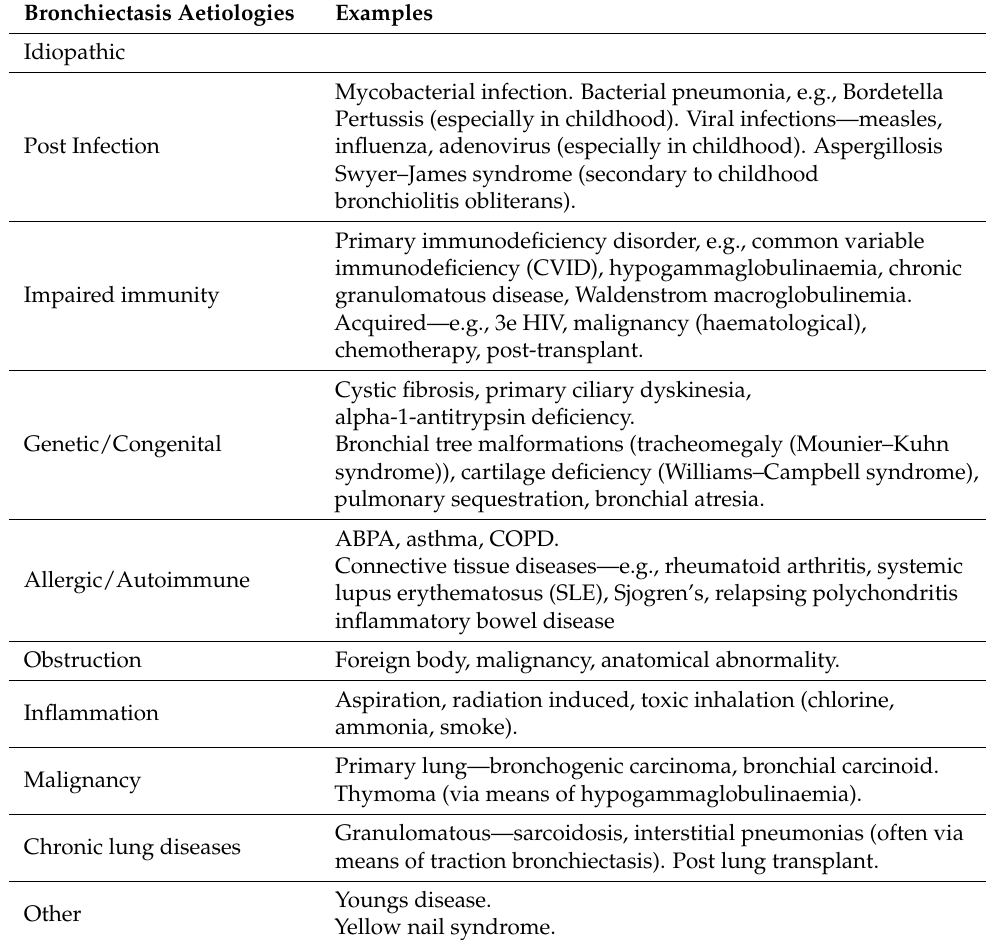
Table 1. Aetiologies of